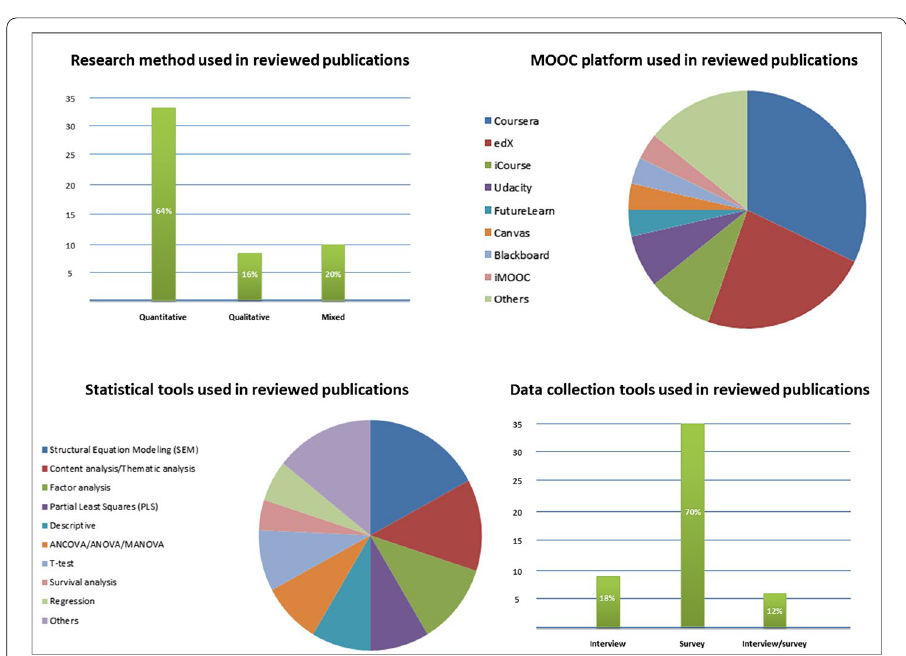
Fig. 2 Overview of research methods, MOOCs platforms, statistical tools, and data collection tools used in reviewed